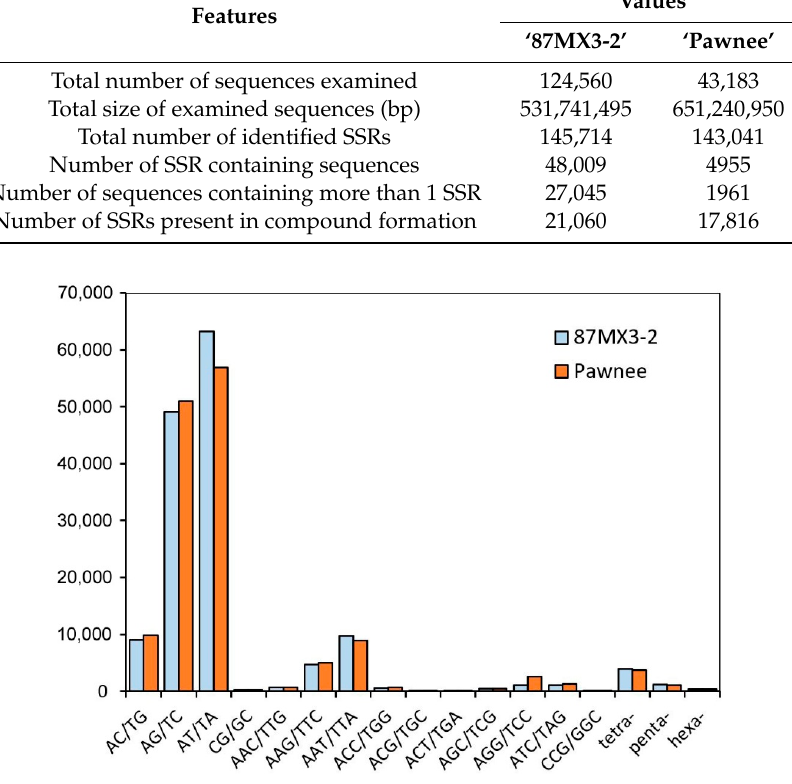
Figure 2. The motif distribution pattern of pecan genomic simple sequence repeats (gSSRs) (considering sequence complementary).